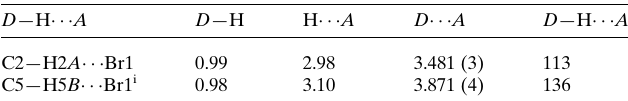
Table 2 Hydrogen-bond geometry (A˚ , (cid:2) ).